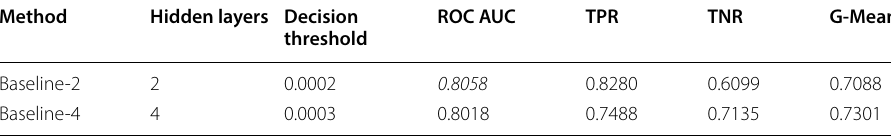
Italic font indicates the maximum ROC AUC score Table 12 Average results of traditional learners (10 runs) Logistic